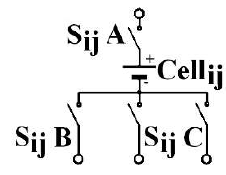
Figure 4. C3C architecture.